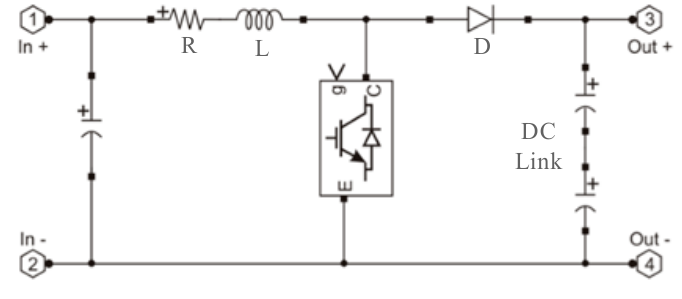
Figure 4. Modelling of Boost Converter.